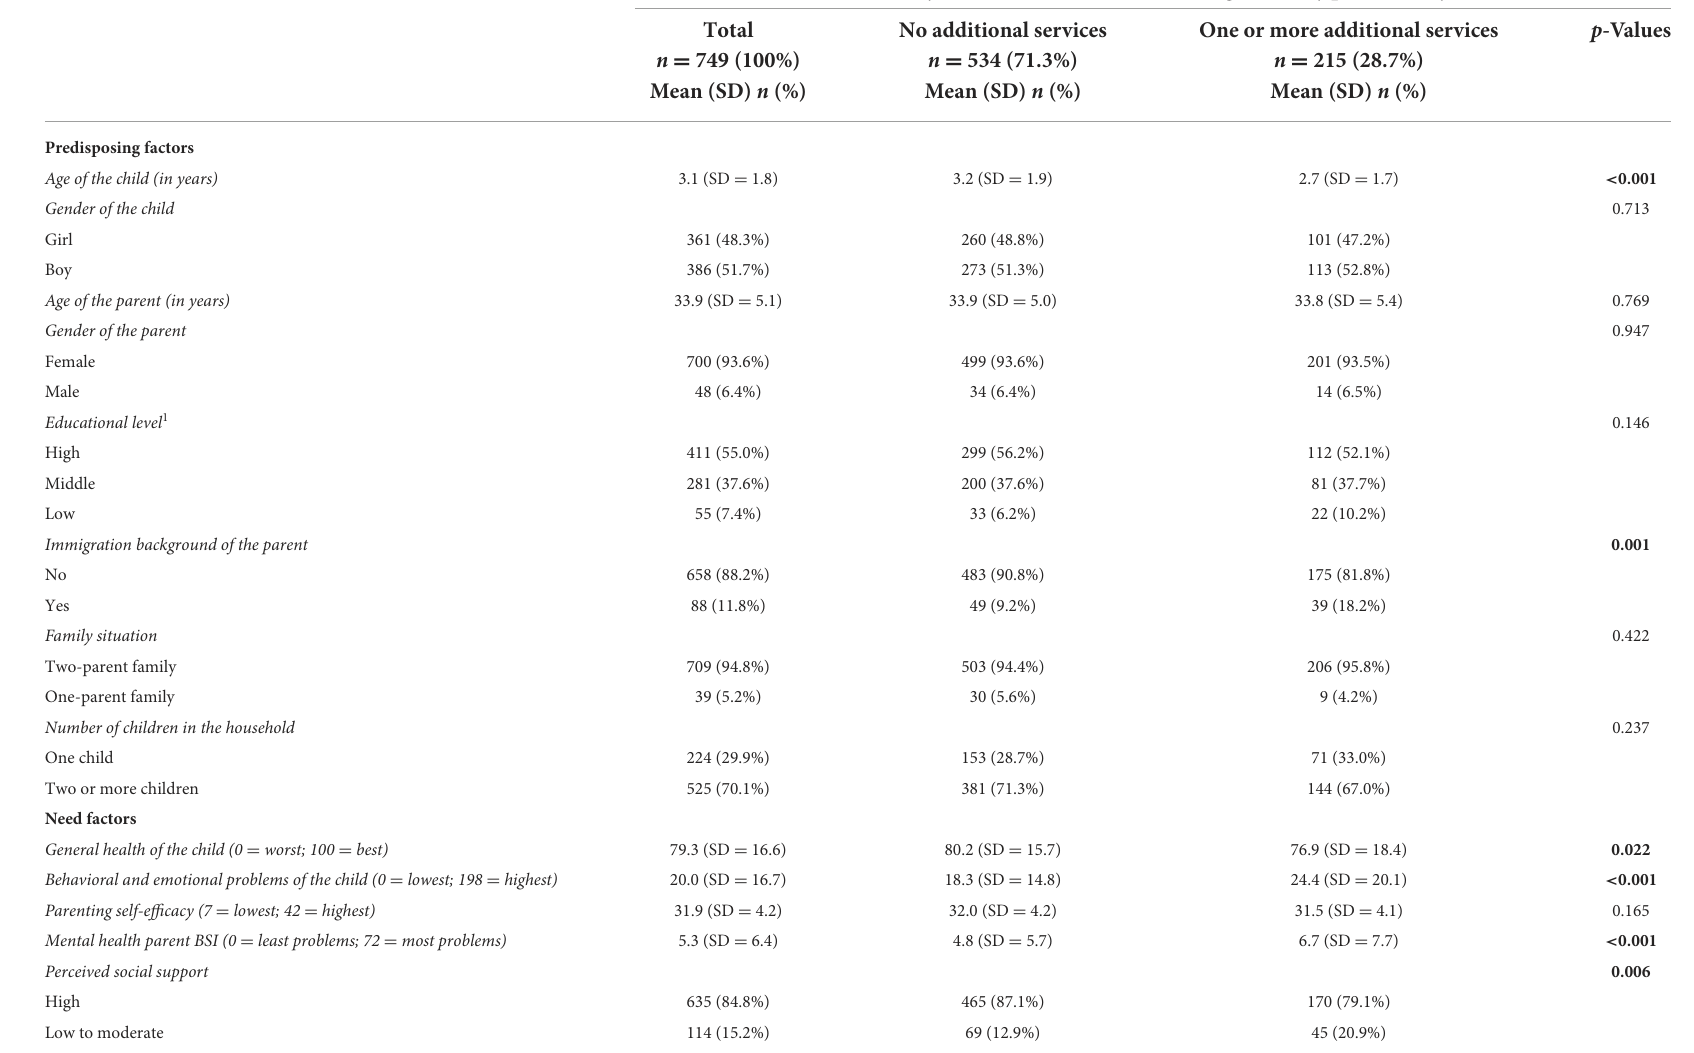
TABLE 1 Characteristics of 749 parents of children aged 1–7 years participating in the CIKEO study by the use of additional community youth health care services during the study period of 1.5 year. Additional youth health care services during the study period (1.5